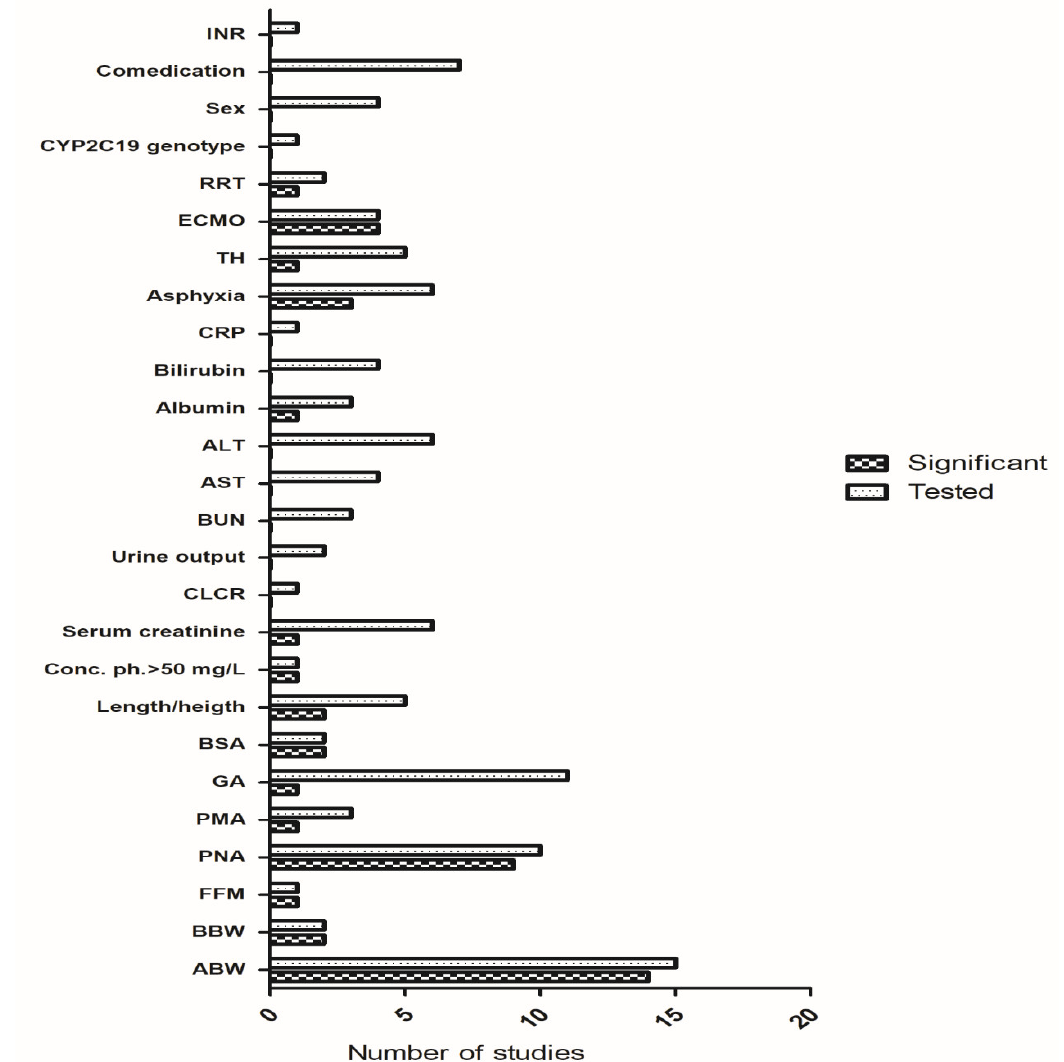
Figure 1. Tested and significant covariates reported in the studies. Abbreviations: ABW = actual body weight, AST = aspartate transaminase, ALT = alanine transaminase, BBW = birth body weight, BSA = body surface area, BUN = blood urea nitrogen, CLCR = creatinine clearance, CRP = C-reactive protein, FFM = fat-free mass, GA = gestational age, ECMO = extracorporeal membrane oxygenation, INR = international normalized ratio, PNA = postnatal age, PMA = postmenstrual age, RRT = renal replacement therapy, TH = therapeutic hypothermia.